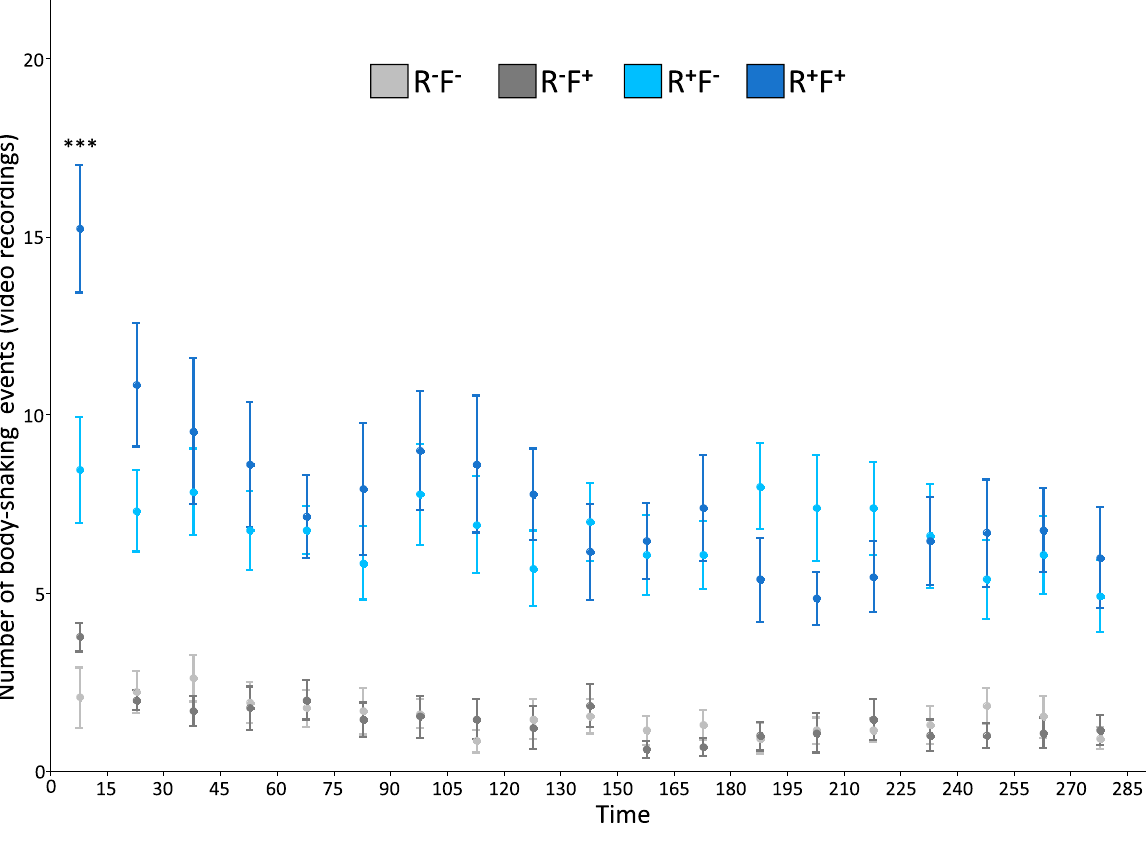
Figure 3. Total number of the body-shaking events (video recordings) over time, with a timeframe set to 15 s. Treatments: absence of reproductives (R − ), presence of reproductives (R + ), absence of flashlight (F − ), presence of flashlight (F + ). Significant effects of the flashlight are represented with * (*** p < 0.001). Note that these models were restricted to the comparison within R+ (blue/light blue) or R− (dark grey/light grey)